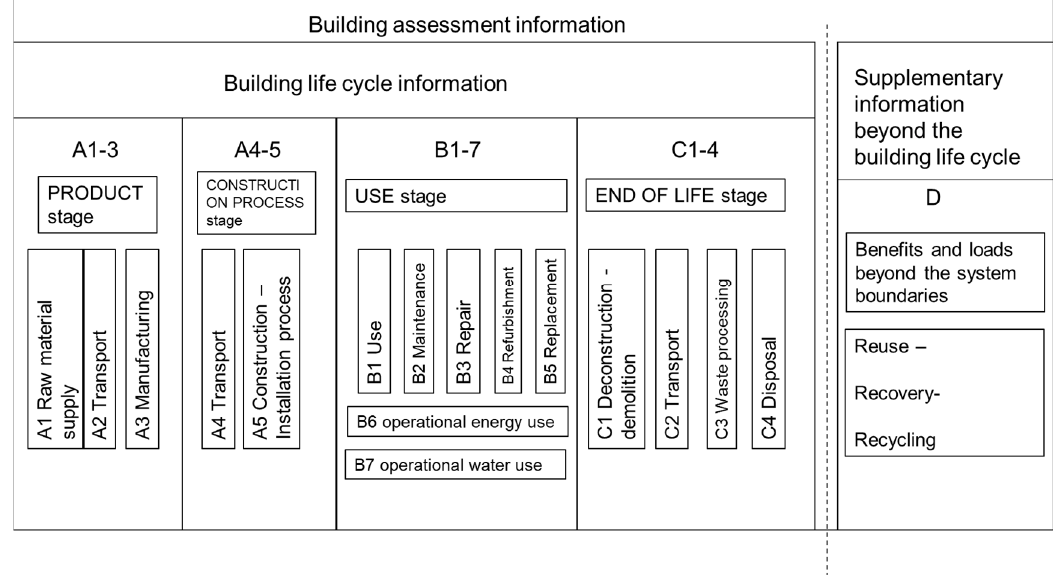
Figure 2. Building Life Cycle Assessment (EN 15978) [23].